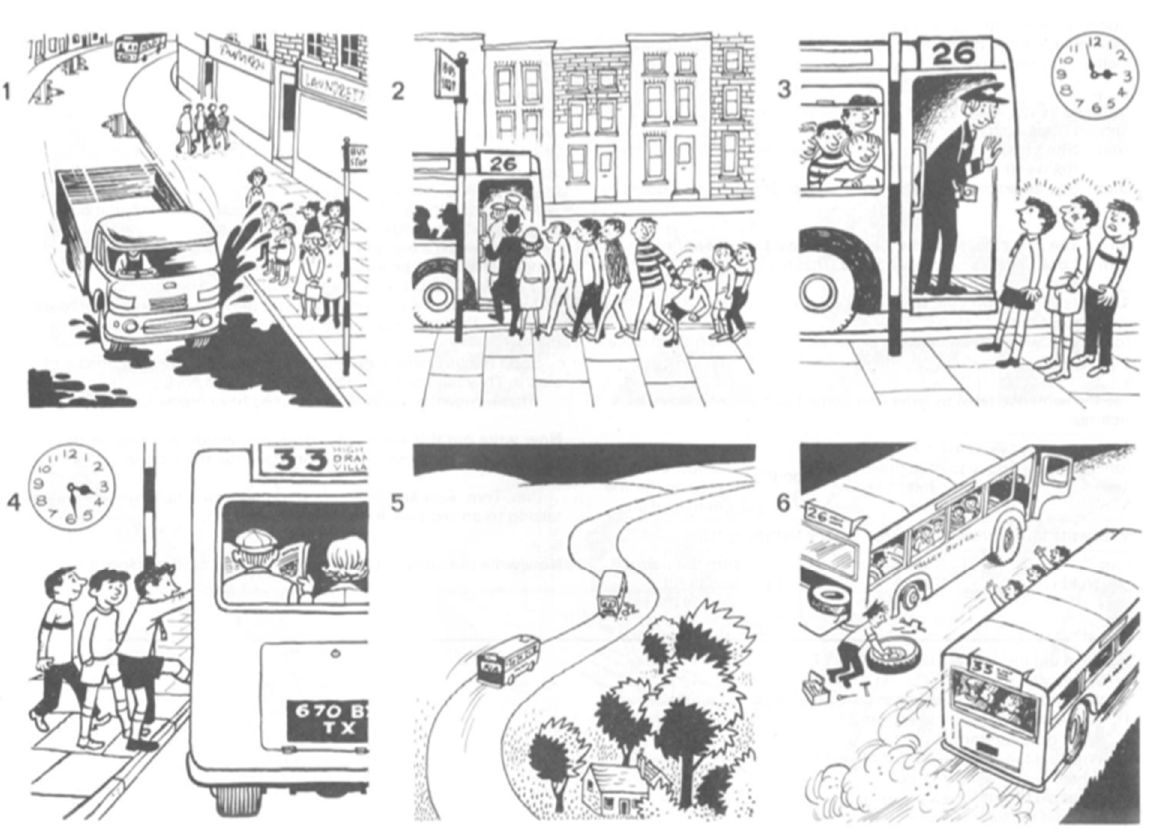
Figure A1. Stimulus for written production task .